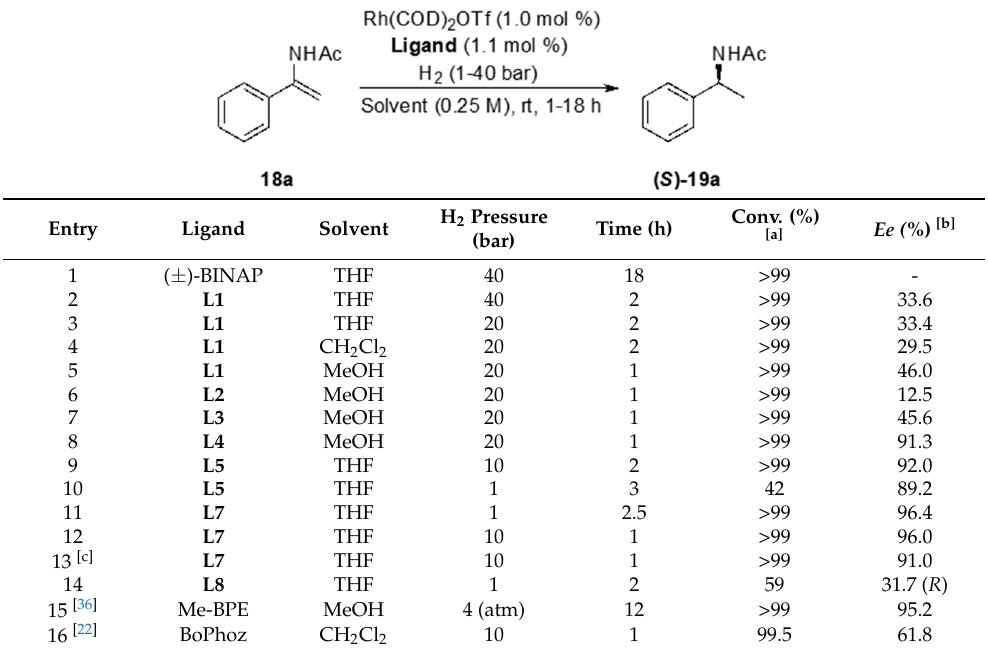
Table 3. Screening of asymmetric hydrogenation conditions with substrate 18a .